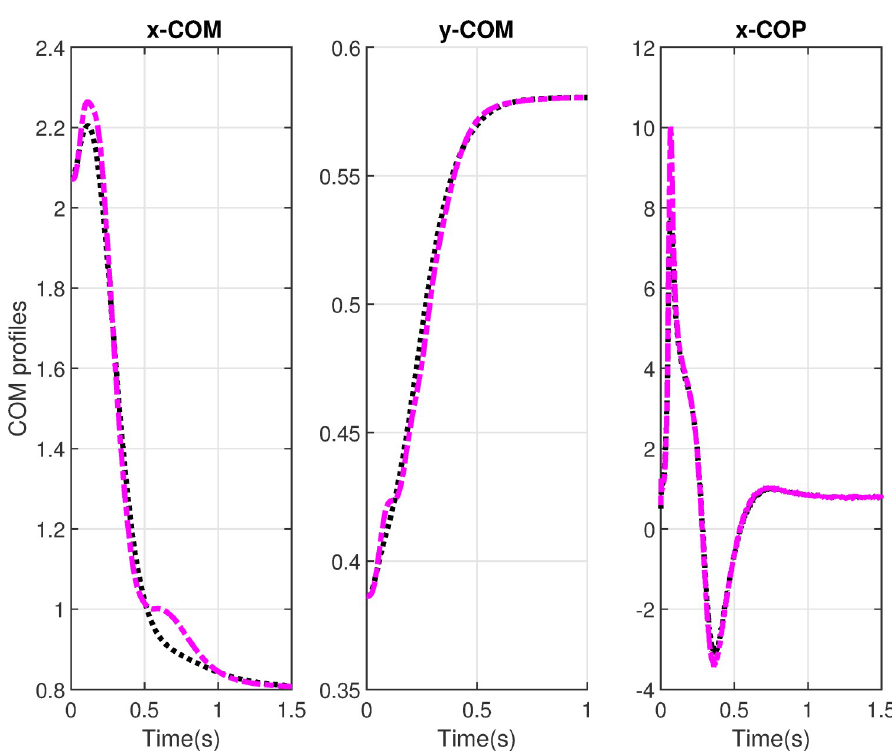
Fig 8. Ground reaction forces profiles. The horizontal GRF-x and vertical GRF-y with and without delays. Black lines show the simulations without delays and purple lines show simulations with delays.